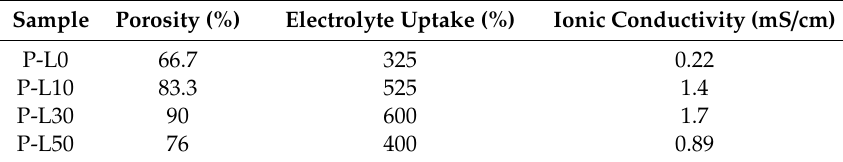
Figure 2. Field emission scattering electron microscopy (FESEM) of ( a ) P-L0; ( b ) P-L10; ( c ) P-L30; and ( d ) P-L50. Table 1. Porosity, electrolyte uptake, and ionic conductivity values of PL